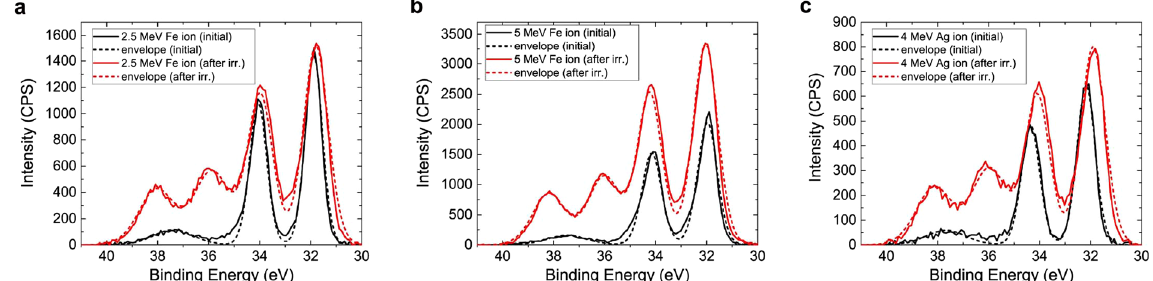
Figure 4. Change of XPS W 4 f peak spectra after heavy ion irradiation. The change of XPS W 4 f spectrum after irradiation with ( a ) 2.5 MeV Fe, ( b ) 5 MeV Fe, and ( c ) 4 MeV Ag ions at a fluence level of 10 16 ions/cm 2 . The XPS spectrum intensity is expressed in the units of counts per second (CPS). The appearance of two additional peaks at ~36 eV and ~38 eV after irradiation indicates the oxidation of tungsten.